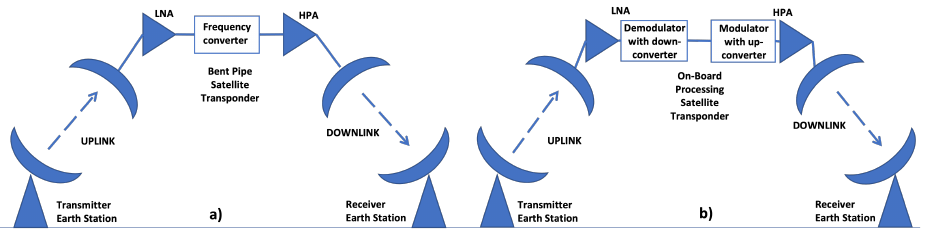
Figure 2. ( a ) Bent pipe transponder satellite; ( b ) on-board processor transponder